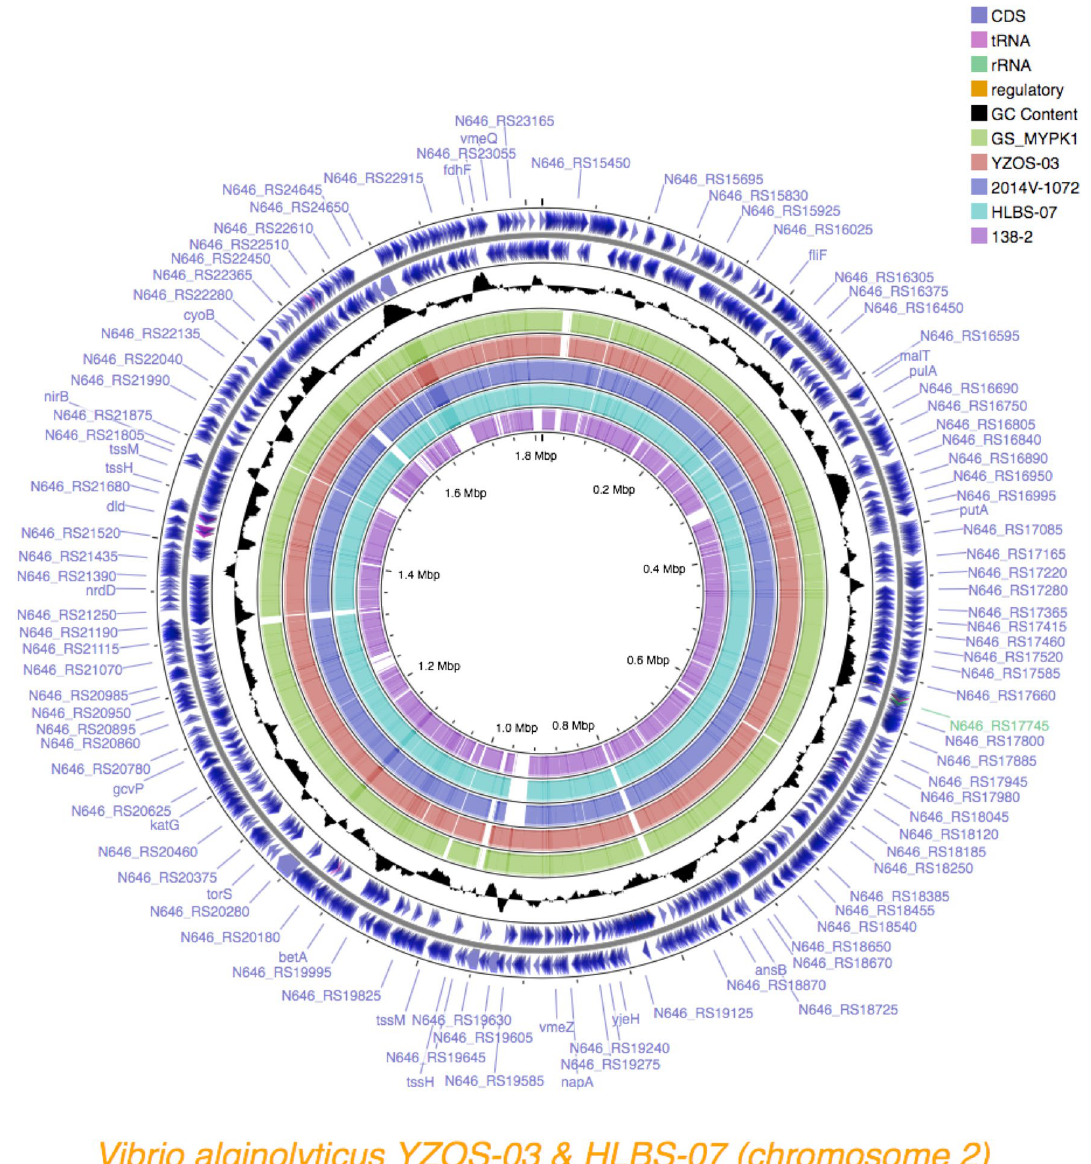
Figure 7. Structure of chromosome2 of Vibrio alginolyticus . Chromosomal sequences of V. alginolyticus G3_MYPK1, 2014V-1072,138-2 HLBS-07 and YZOS-03 strains were mapped based on NBRC15630. CDSs were estimated with Prokka on the